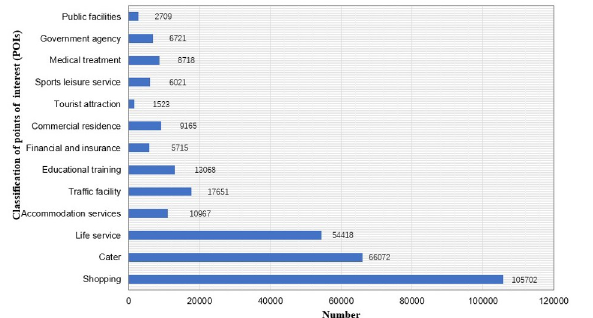
Fig 6. Data distribution of urban points of interest (POIs).